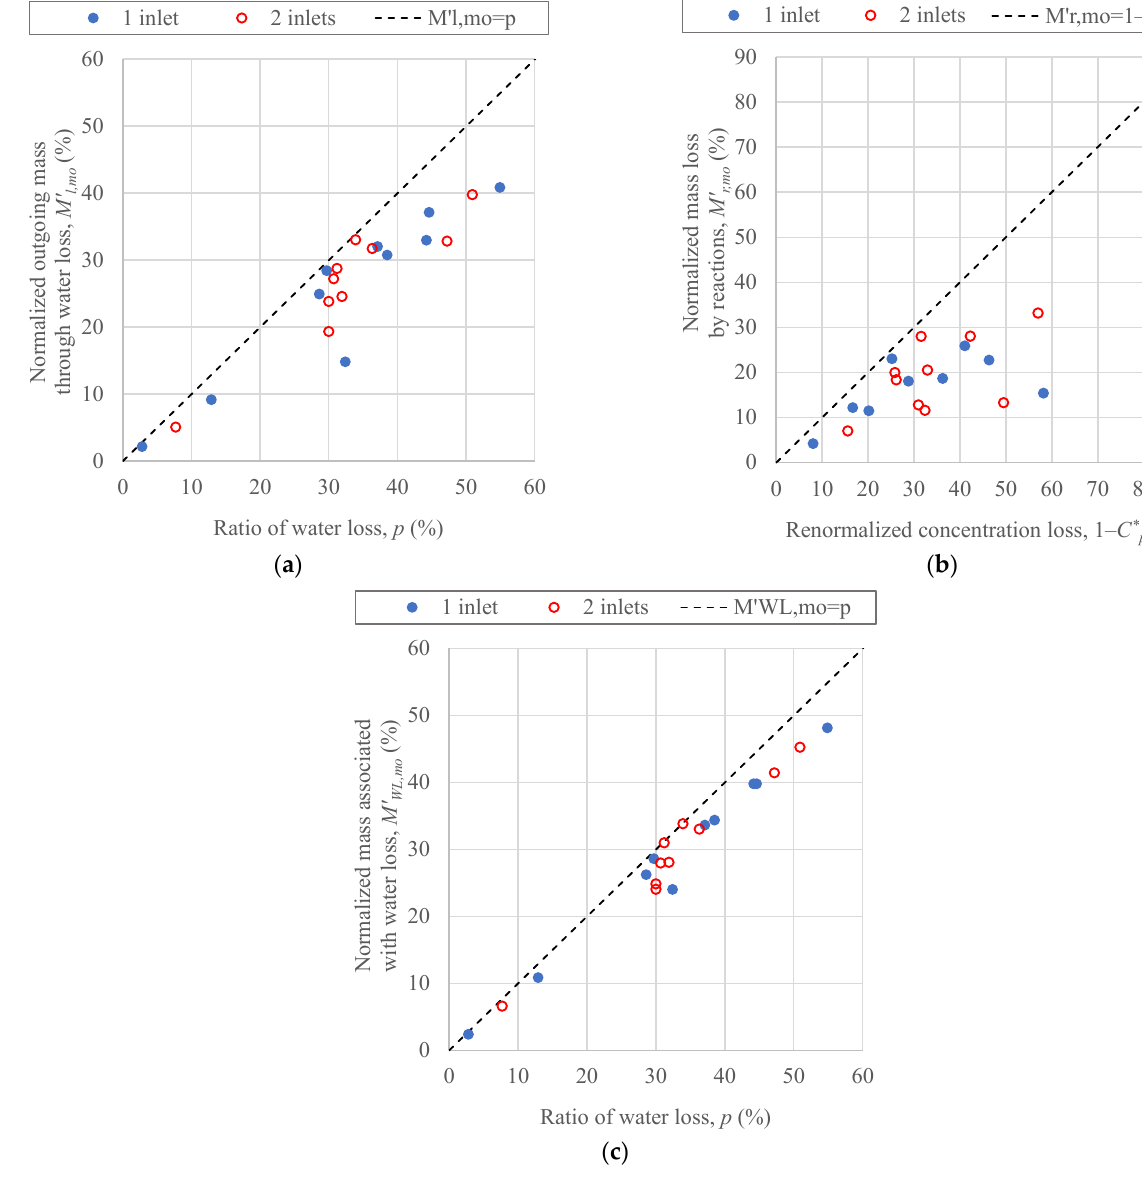
Figure 6. Relationships between disinfectant mass balance components, calculated using EPANET models and basic network parameters. ( a ) 𝑀 (cid:3039),(cid:3040)(cid:3042)(cid:4593) vs. 𝑝 , ( b ) 𝑀 (cid:3045),(cid:3040)(cid:3042) (cid:4593) vs. 1 − 𝐶 (cid:3043) ∗ , and ( c ) 𝑀 (cid:3024)(cid:3013),(cid:3040)(cid:3042) (cid:4593) vs. 𝑝 .